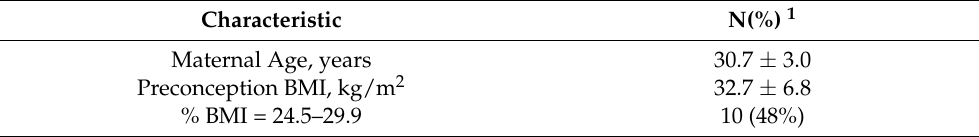
Table 1. Baseline Descriptive Characteristics of Pregnant Women with Overweight and Obesity ( n =